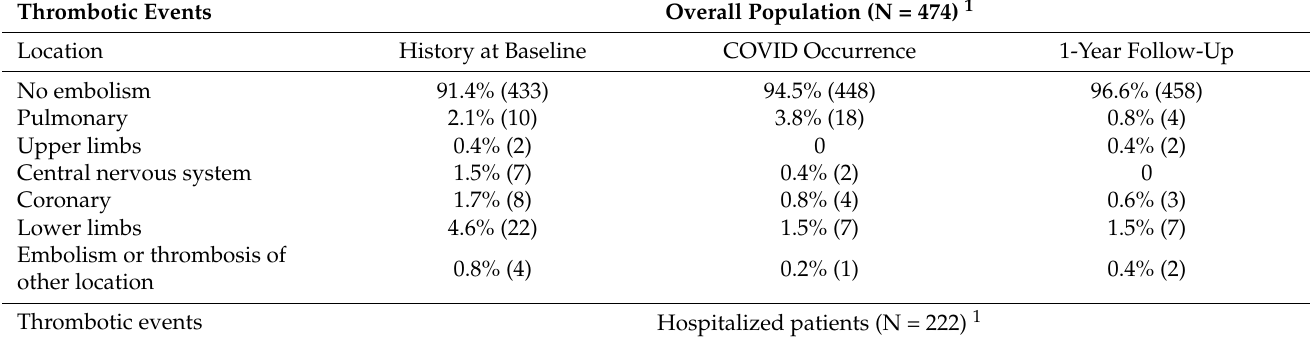
Table 3. Occurrence of thrombotic